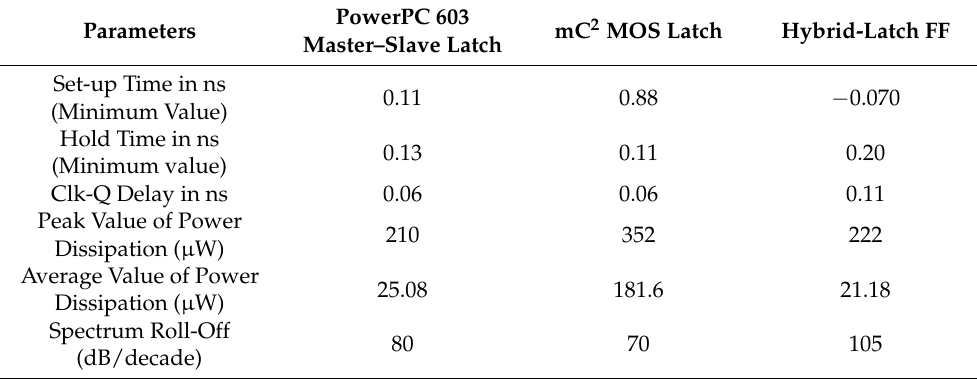
Table 6. Simulations results using the BSIM3 transistor model (130 nm process technology).